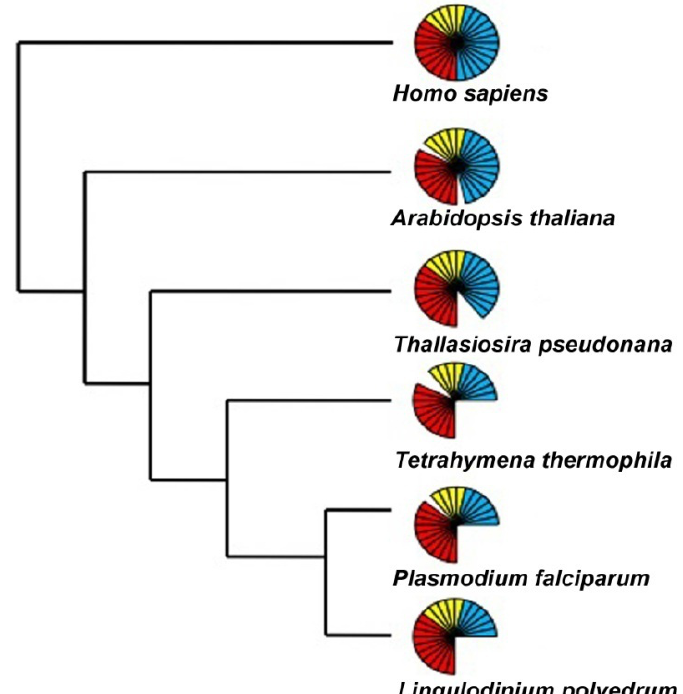
Figure 3. The number of RNA polymerase components present over a wide phylogenetic range of organisms includes those considered to be core components (red), common components (yellow) and specific components (blue) of the RNAP I, II and III. Each bar represents an individual component. The representative sequences for the RNA polymerase I, II and III subunits were selected from an animal ( H. sapiens ), a plant ( A. thaliana ), a diatom ( T. pseudonana ), and two other alveolates ( T. thermophila and P. falciparum ) and uploaded and maintained as a local database in the Geneious software. Using tBLASTn and an expect E-value cutoff of e − 25 , the Lingulodinium transcriptome was scanned to obtain the homologues for the RNA polymerase subunits [41]. For all other species the sequences were directly obtained from the KEGG specific pathway database by selecting the specific